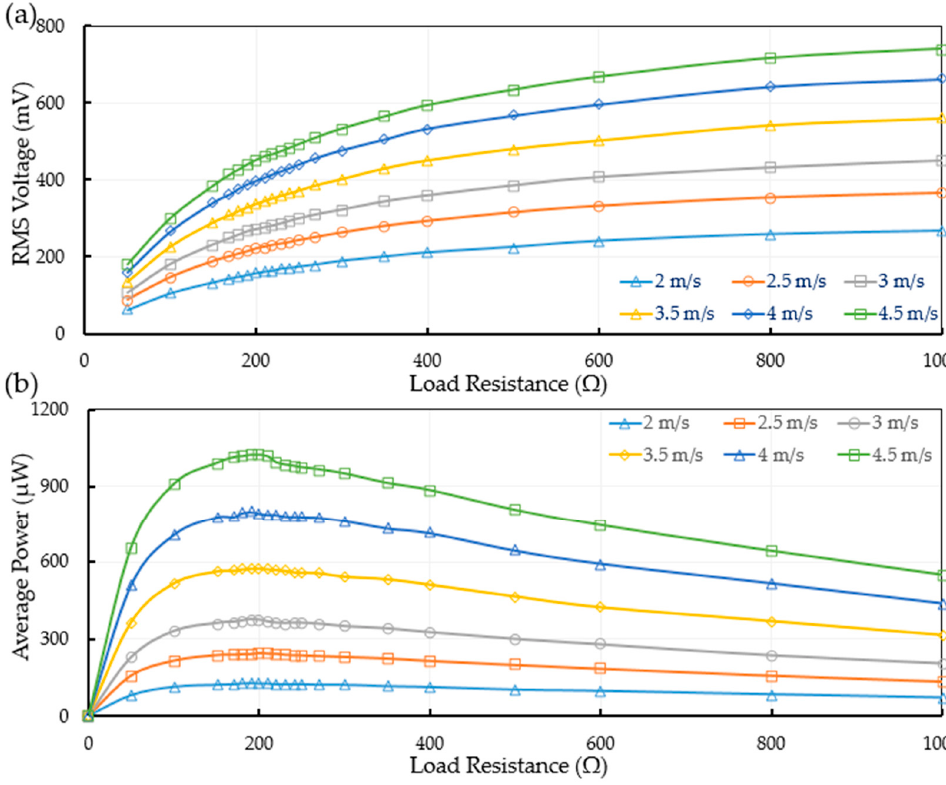
Figure 6. The values of ( a ) RMS voltage and ( b ) average power versus load resistances obtained from the EMWEH prototype under various wind speeds.